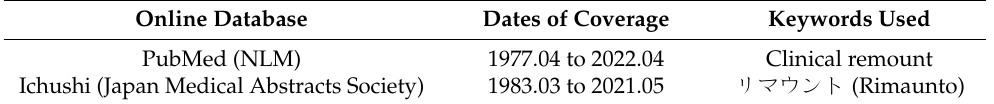
Table 1. The search methodology applied for each database. Online Database Dates of